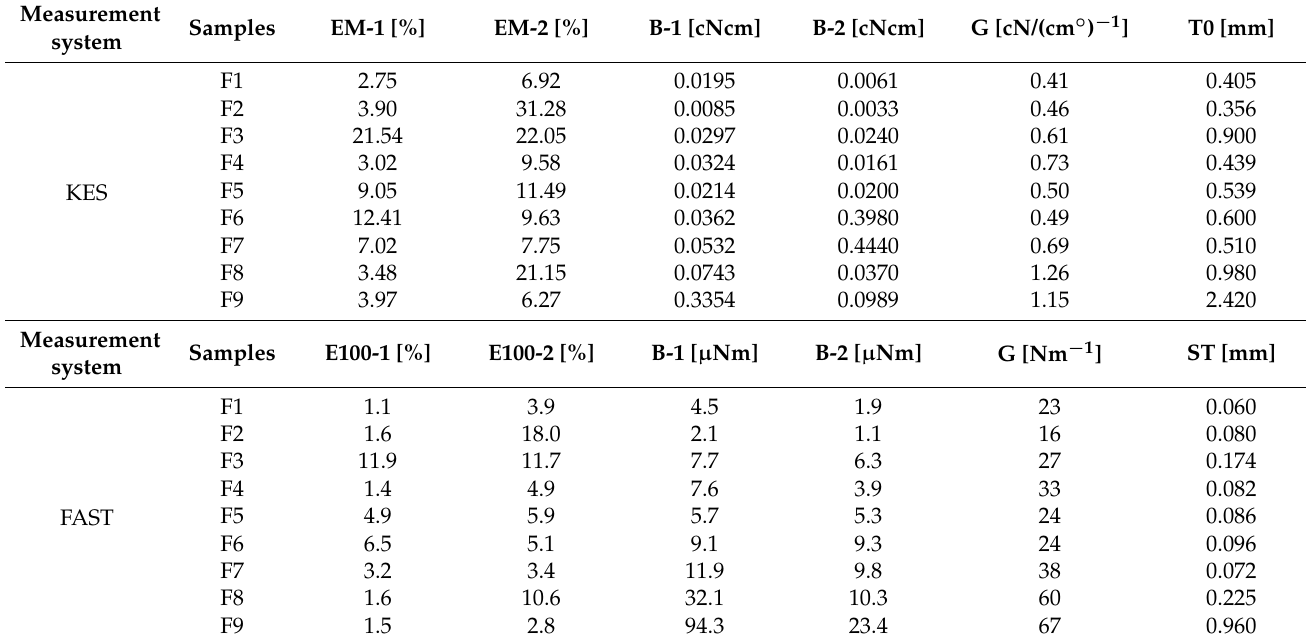
Table 2. Values for the mechanical properties of fabrics determined by KES and FAST system (suffix 1 refers to warp direction and suffix 2 to weft